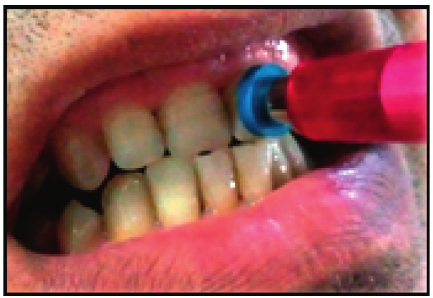
Figure 3: The customized positioning